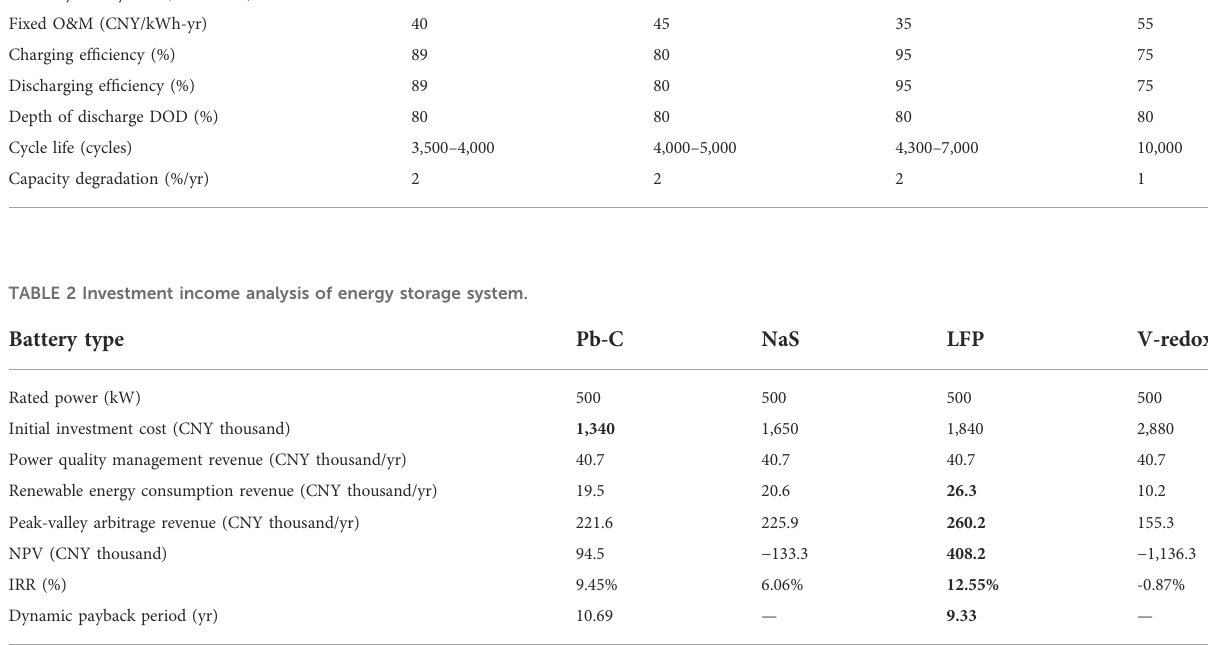
Bold values represent the optimal value in this comparison term for the four types of